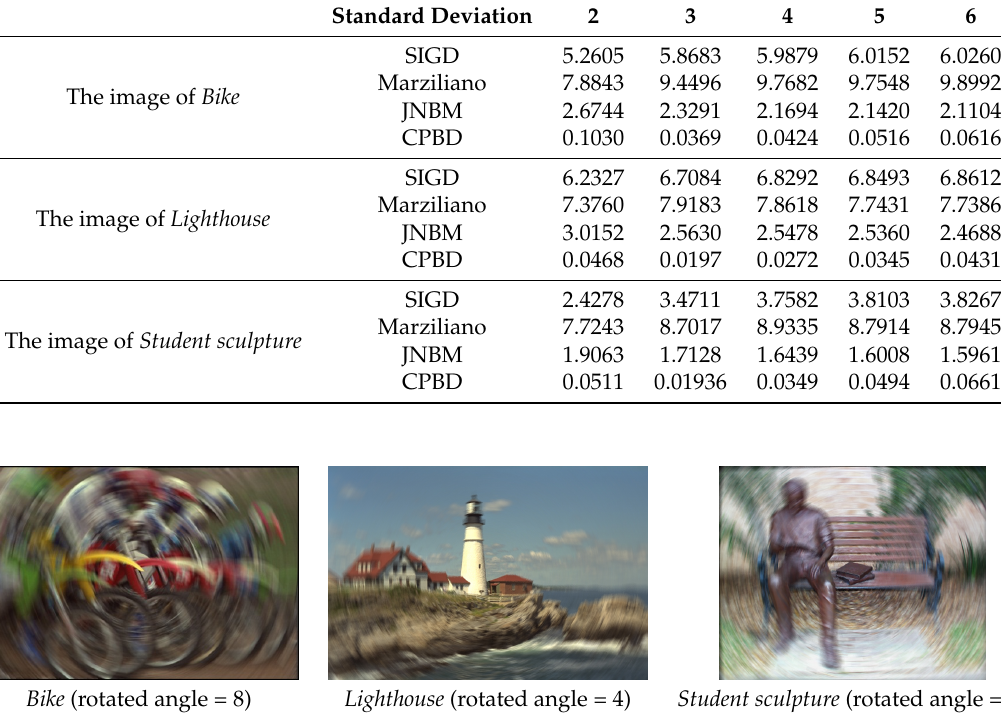
Figure 5. Three rotation motion blurred images used in our experiments. Table 3. Estimated blurred degree on Gaussian blurred